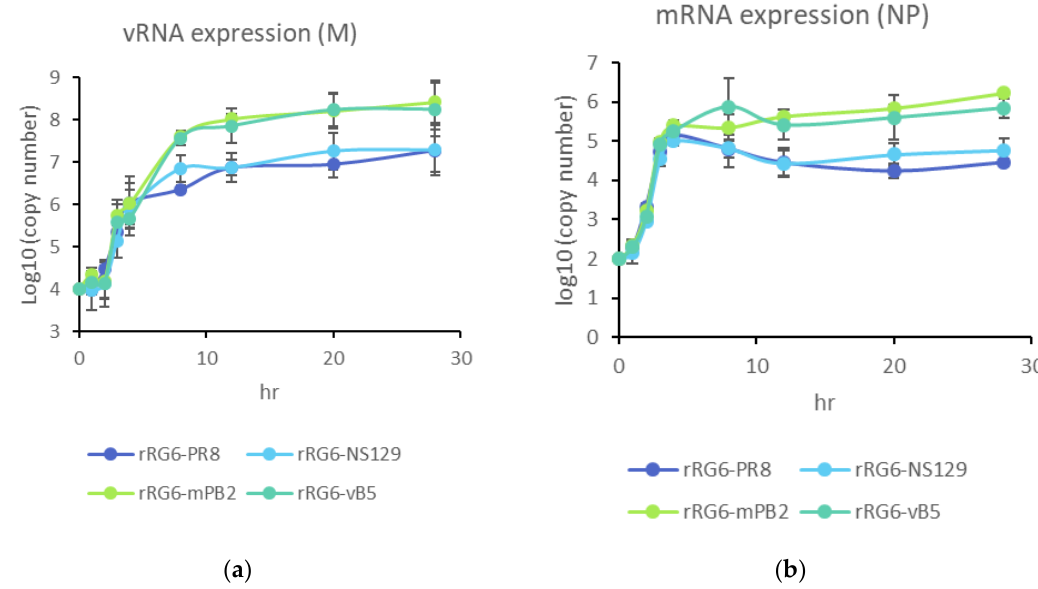
Figure 7. RNA expression in Vero cells after influenza virus infection. Vero cells were infected with 10 MOI. After 0, 1, 2, 3, 4, 8, 12, 20, 28 h post infection, cells were lysed by freeze-thaw action, and extracted total RNA. vRNAs were reverse-transcribed using Uni12 primer ( a ), and mRNAs were measured by using oligo dT primer ( b ).